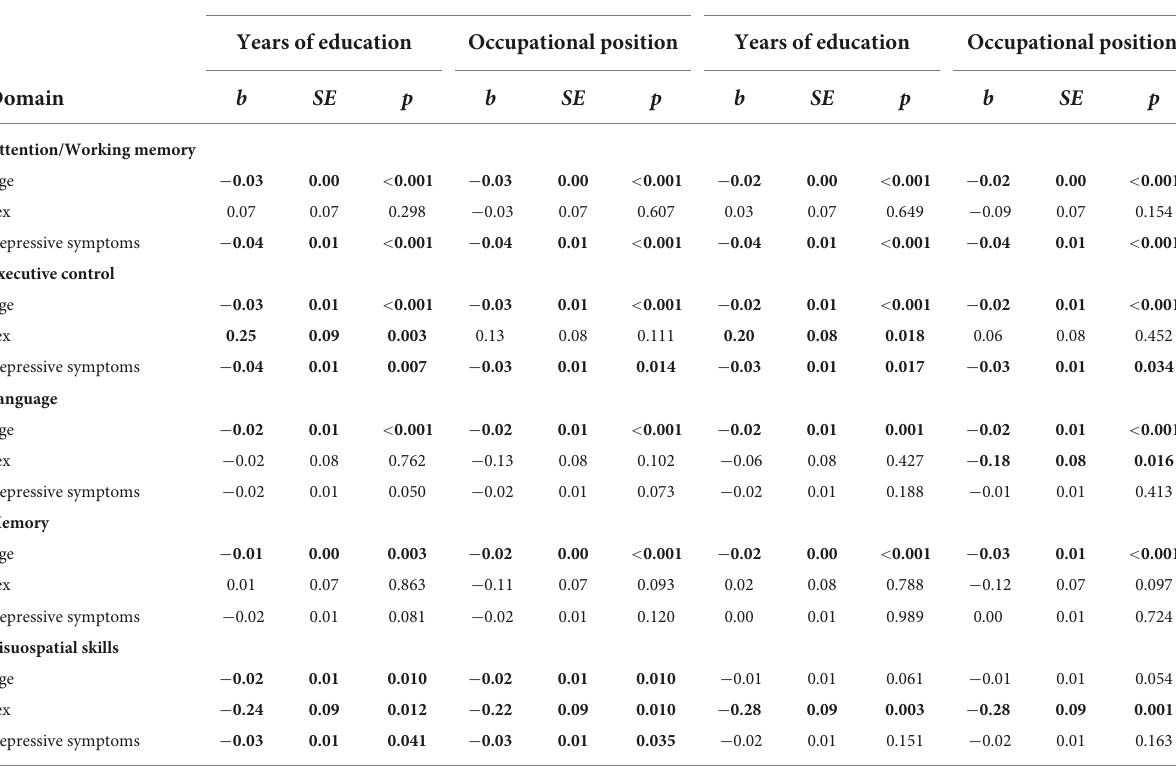
TABLE 3 Covariate effects from moderation analyses for participants without